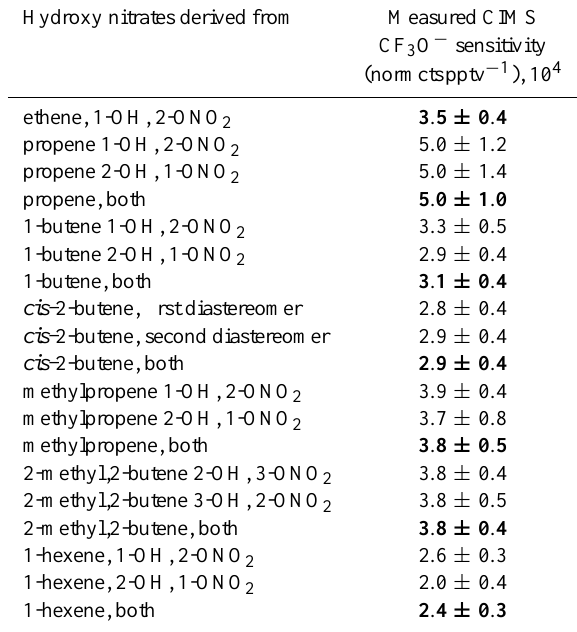
Table 2. Absolute sensitivities for each individual isomer and isomer-averaged sensitivities (bold) were determined by summing peaks in both the CIMS and TD-LIF, and deriving a sensitivity, expressed as normalized counts of analyte ion (normcts) per pptv of analyte. Uncertainties (1 σ ) include the 10% uncertainty from the split ratio and absolute NO 2 determination by the TD-LIF. The measured 1-hexene HN sensitivities are lower than other HNs mea- sured in this study. This may reflect precision errors for this one compound, and thus lead to a high biasing in the HN branching of 1-hexene and 1-octene. Hydroxy nitrates derived from